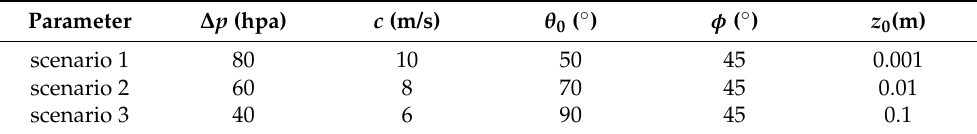
Table 1. ETC parameters for wind field simulation.